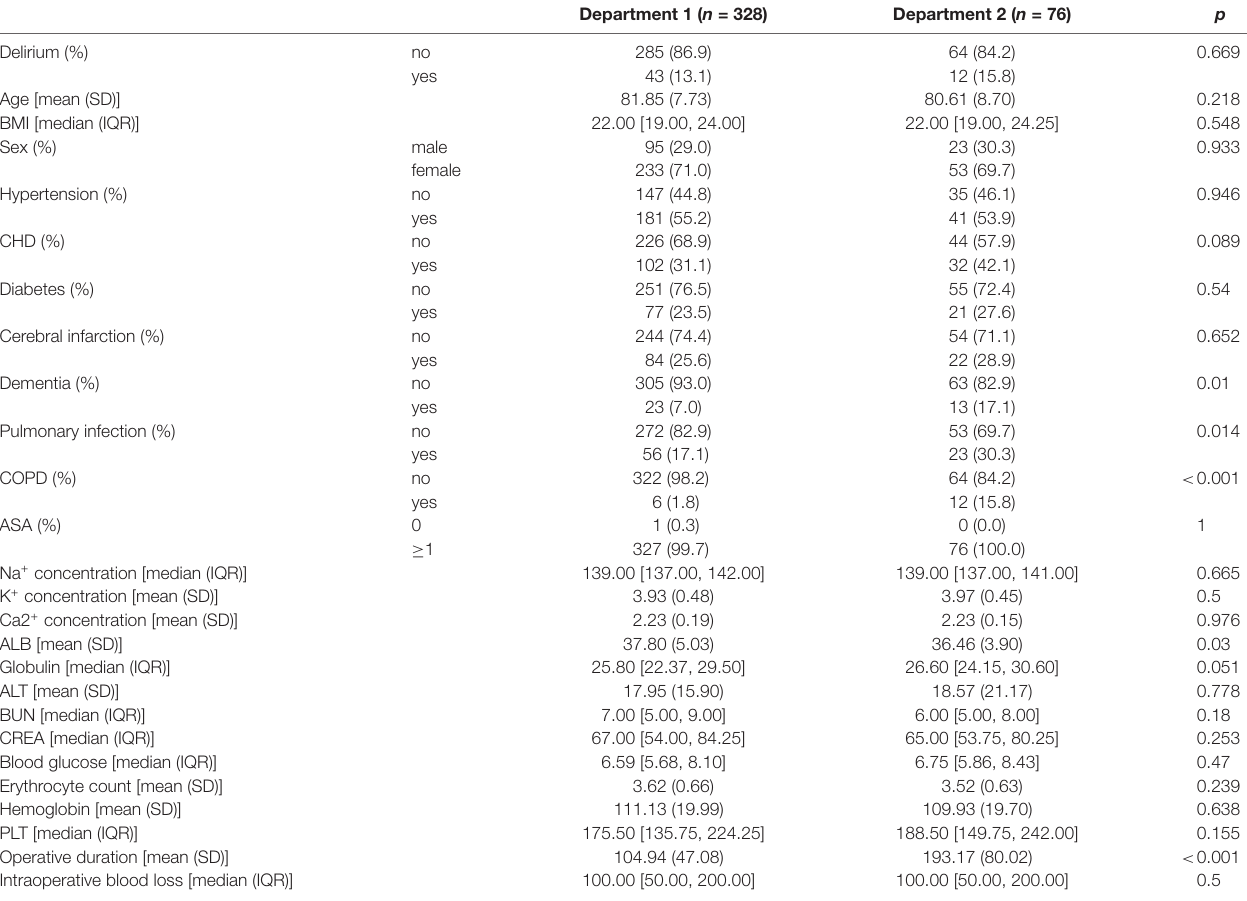
TABLE 1 | Patient characteristics of the department 1 and department 2.